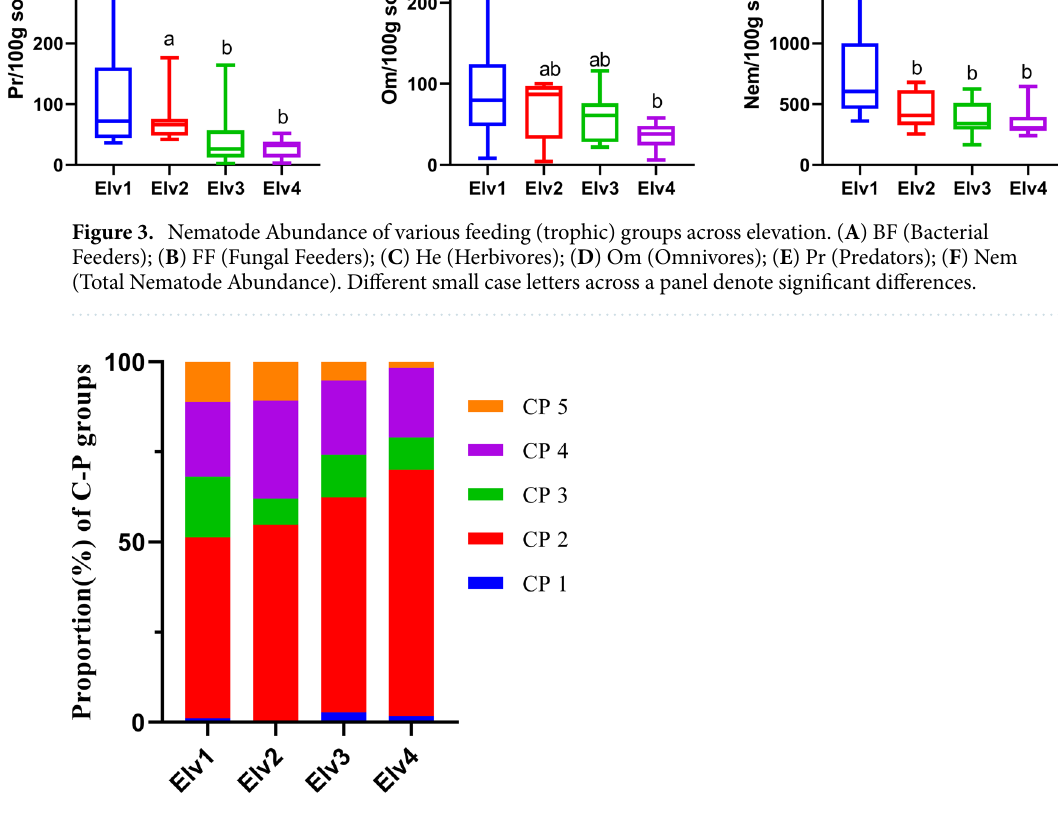
Figure 4. Relative abundance (%) of nematode C–P groups at four different elevation